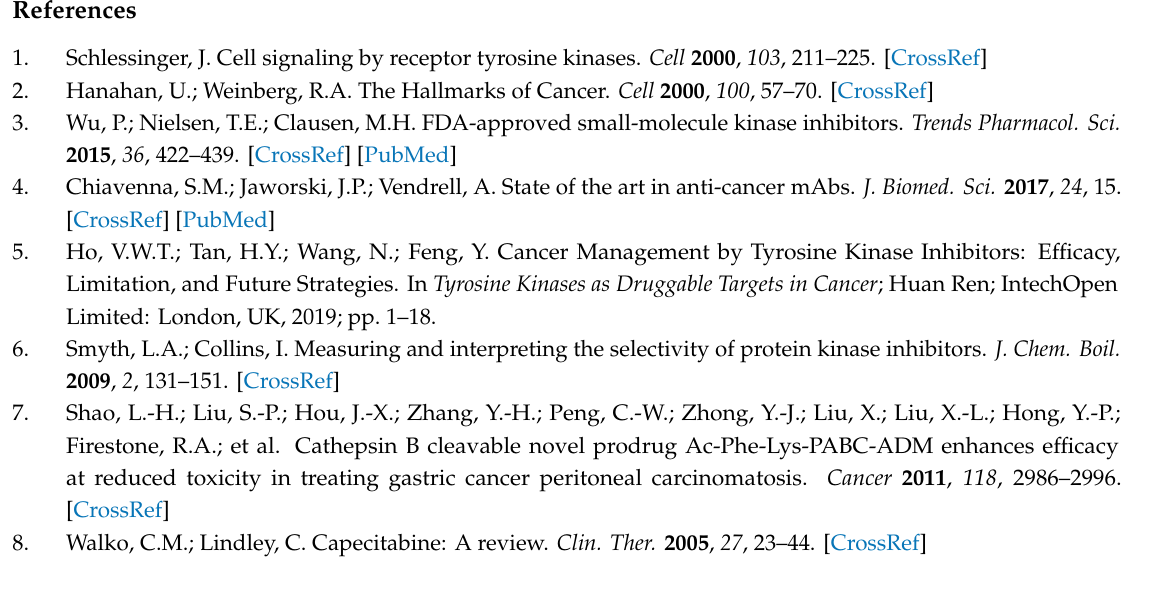
Supplementary Materials: The following are available online: Figure S1: grid sizes of the docking studies, Figure S2: 2D interactions of the prodrugs with the kinases. Table S1: docking scores. Figure S3: BOILED-Egg plots. Figure S4: Stability assay. Table S2 and Figure S5: kinase inhibition data. Figures S6 and S7: H 2 O 2 prodrug activation data. Figure S8: Docking studies of compound C . Table S3: Docking scores of compound C . Figures S9–S14: 1 H and 13 C NMR of prodrugs A and B and compound C